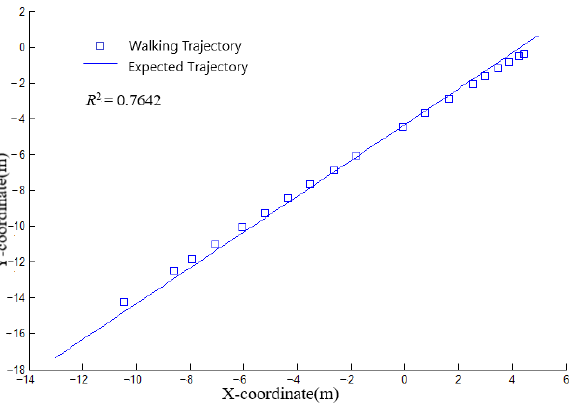
Figure 20. X-Y coordinates of SMC.